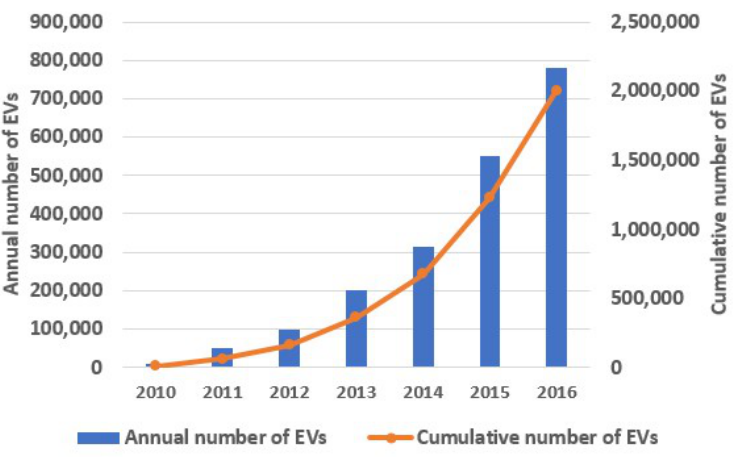
Figure 4. The number of electric vehicles (EVs) from 2010 to 2016 in the USA (annually and cumulative), derived from